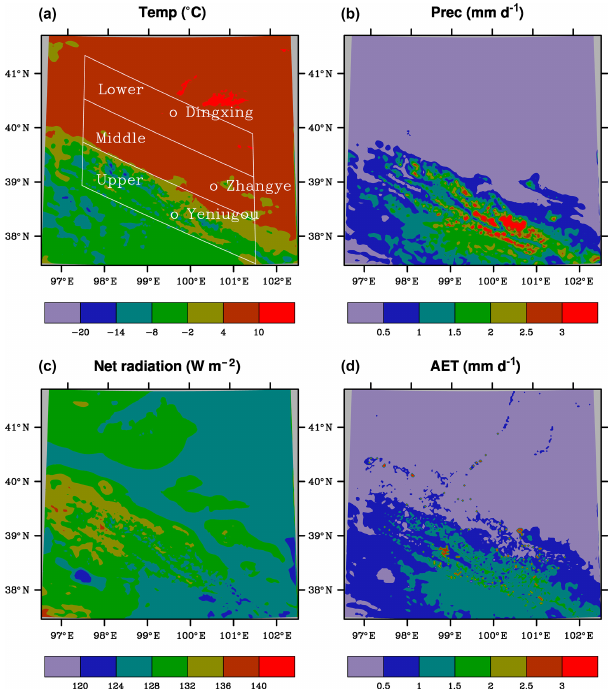
Figure 2. Spatial distributions of the simulated air temperature ( T , ◦ C), precipitation ( P , mmd − 1 ), net radiation (NRAD, Wm − 2 ), and actual evapotranspiration (AET, mmd − 1 ) averaged over 1980– 2010. The Heihe River basins and weather stations are shown in (a)